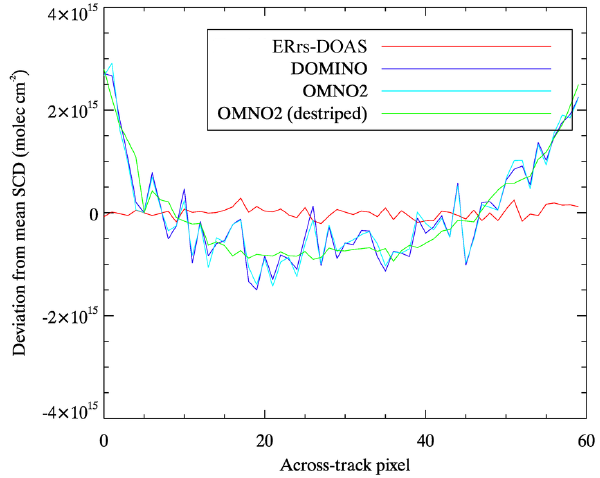
Figure 11. Deviations from the across-track mean NO 2 SCD retrieved by the Earth radiance reference algorithm and the OMNO2 and DOMINO algorithms. The Earth radiance L1B and OMNO2/DOMINO L2 data were taken from orbit no.